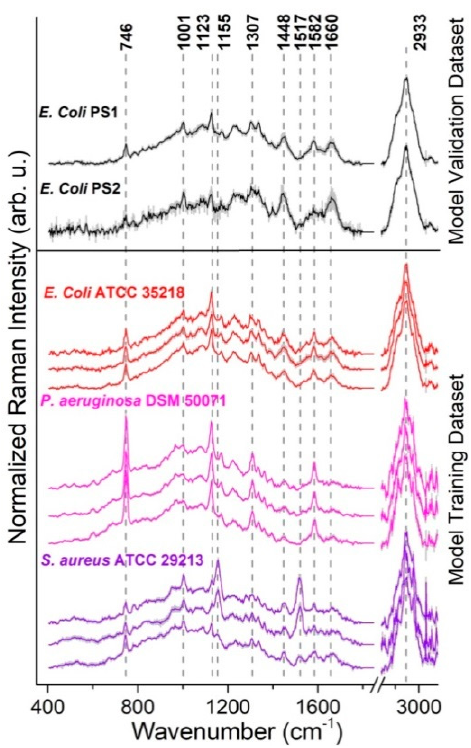
Figure 4. Mean Raman spectra and their double standard deviation of bacteria species included in the Raman database (3 independent batches/bacterium species for the PCA-LDA model training dataset). For each batch 25 Raman spectra were measured at randomly selected